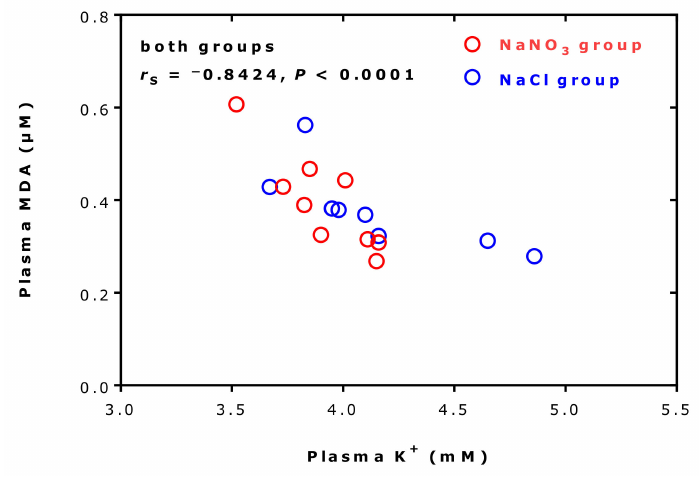
Figure 6. Relationship between the baseline plasma MDA and K + concentrations in the volunteering persons of the NaCl and NaNO 3 groups. Each symbol corresponds to a single volunteering person.